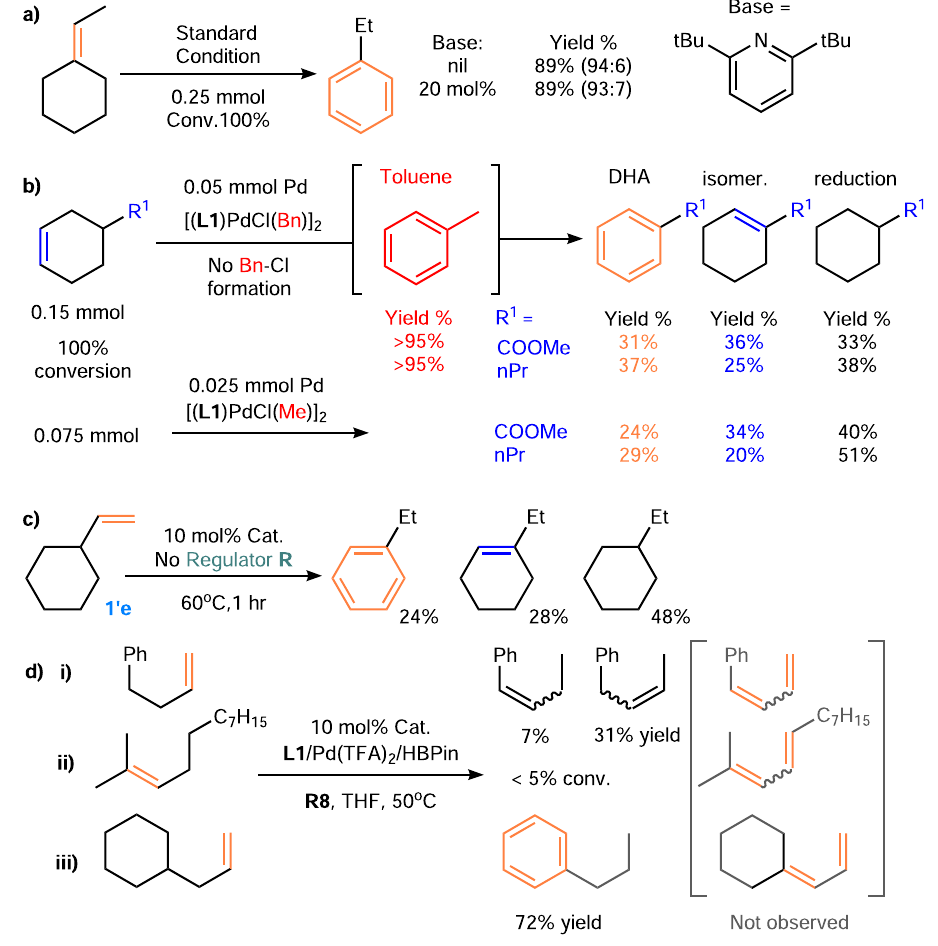
Fig. 7 | Control experiments and mechanistic studies. a Exocyclic ole fi n DHA using excess base. b Using [( L1 )PdCl( R )] 2 as an initiator in a mimic of the